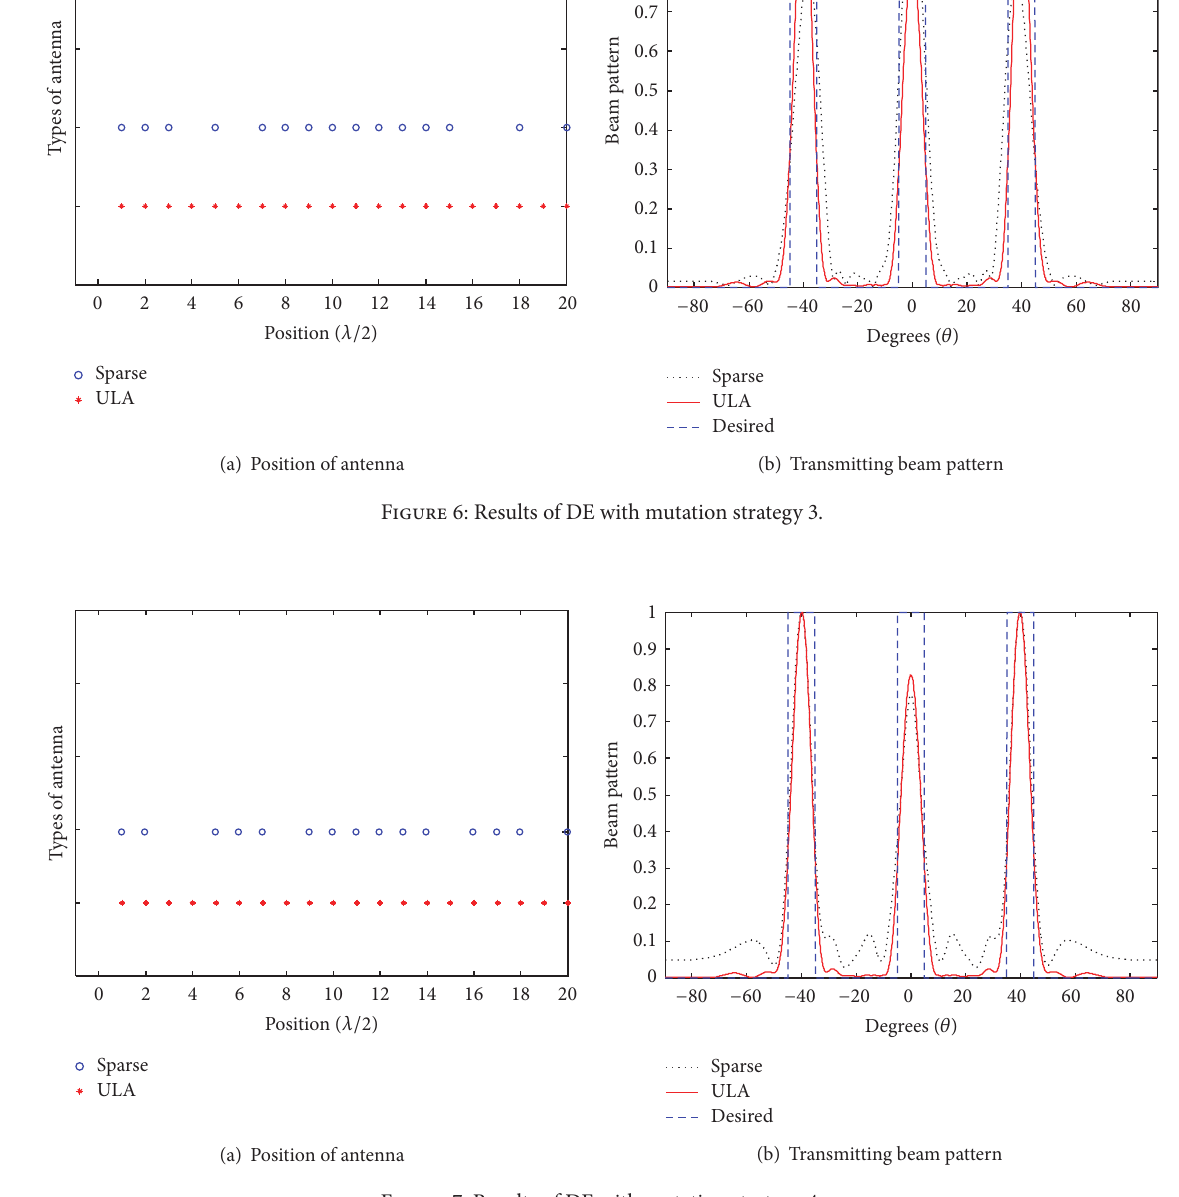
Figure 7: Results of DE with mutation strategy